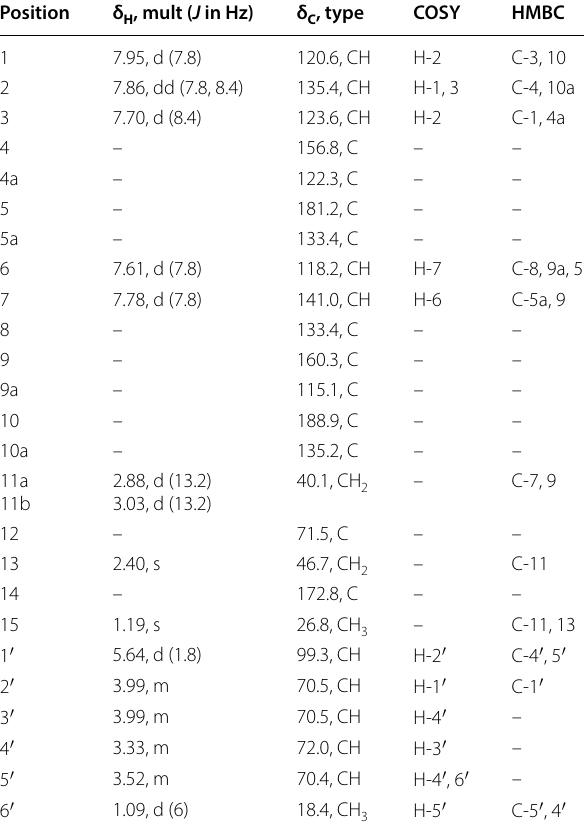
Table 2 1 H and 13 C NMR data (DMSO-d of